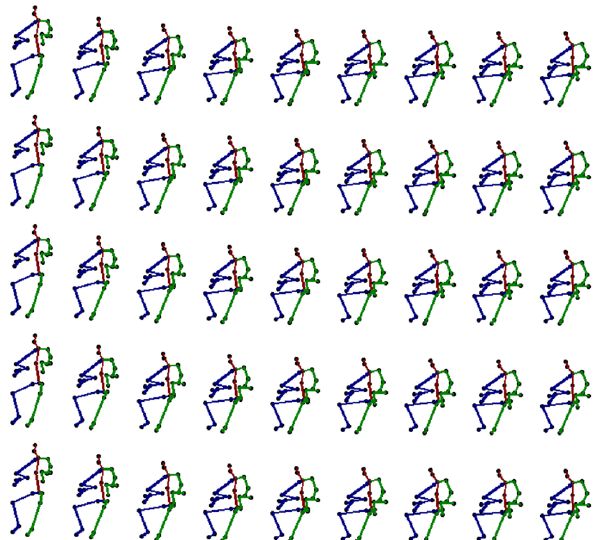
Figure 11. The synthetic sequences derived from the proposed DNN method, shown in 3D presen ‐ tation (a sitting down action was performed by five different